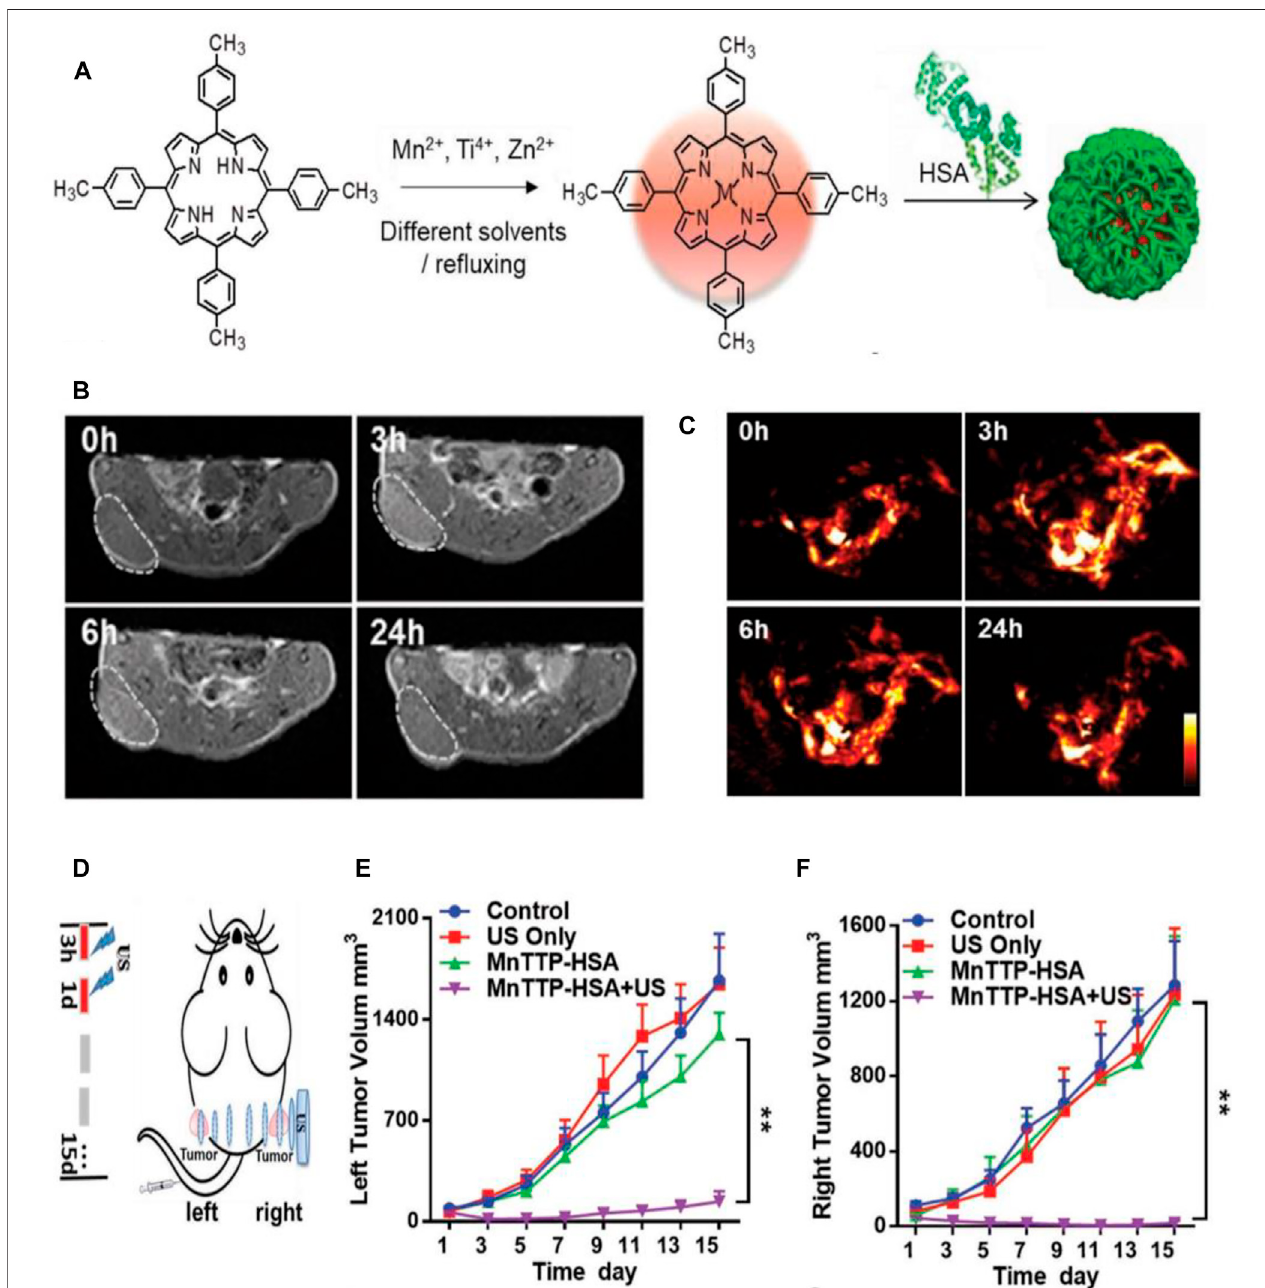
FIGURE 7 | Sonodynamic therapy (SDT)-based cancer theranostics. (A) Schematic illustration of the synthesis procedure of three metal 4-methylphenylporphyrin (TTP) complexes(MnTTP,ZnTTP,andTiOTTP) andthecorrespondingnanocomplexes ofMTTP – HSA. (B) The invivo T 1 -weighted MRimages ofMCF-7 tumor-bearing nudemiceafterthei.v.injectionofMnTTP – HSA. (C) The invivo PAimagesofMCF-7solidtumorsafteri.v.injectionofMnTTP – HSA. (D) The invivo SDTprotocolofMCF- 7 tumor-bearing mouse model with bilateral tumors. The US probe was placed on the right tumor, and the US irradiation was conducted twice at 3 and 24 h, respectively,fromtherightsidetotheleftside(1.0 MHz,2 W/ cm 2 ,50%dutycycle,5 min). (E,F) Thetumorgrowthcurvesoftheleftandrighttumors,respectively,with various treatments (** p < 0.01). Reproduced with permission from Ma et al. (2019). Copyright 2018, WILEY-VCH Verlag GmbH and Co. KGaA, Weinheim.